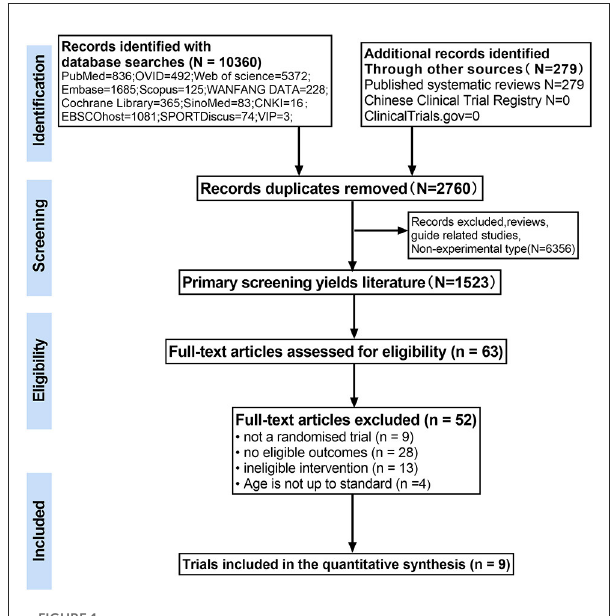
FIGURE1 PRISMA flow diagram chart for systematic review and